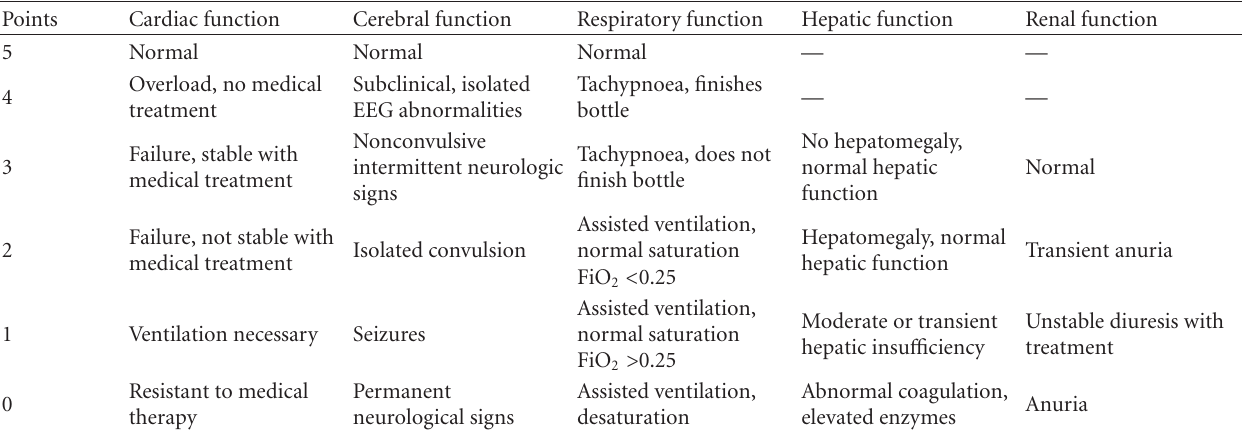
Table 1: Bicˆetre -score for evaluation of the therapeutically management of neonates with VGAM (Lasjaunias PL et al. (2006) [6]).